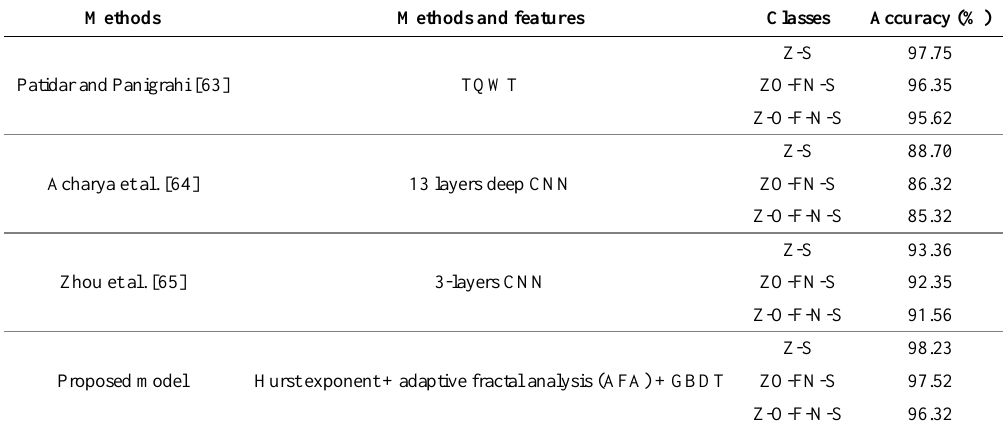
Table 4. Comparison of proposed method results with other